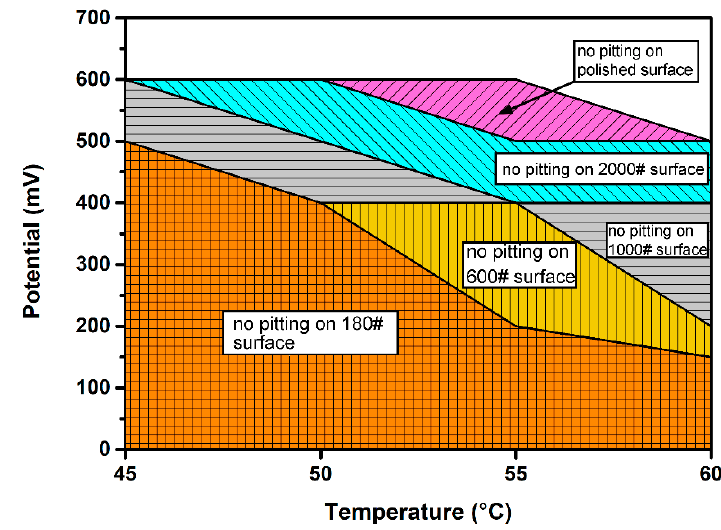
Figure 9. Potentiostatic measurements on different surface roughness specimens at various potentials and solution temperatures.